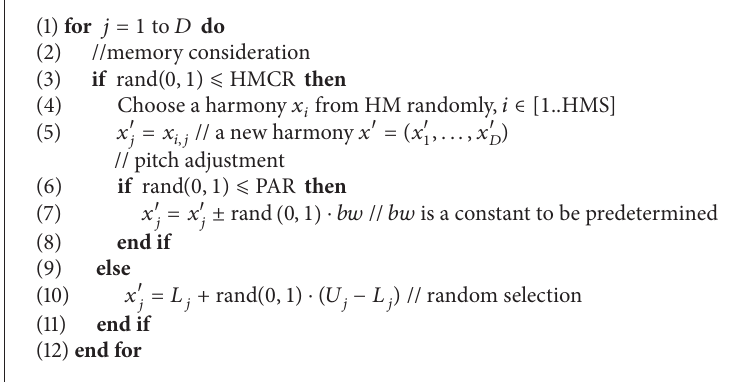
Algorithm 1: The procedure of improvising a new harmony.